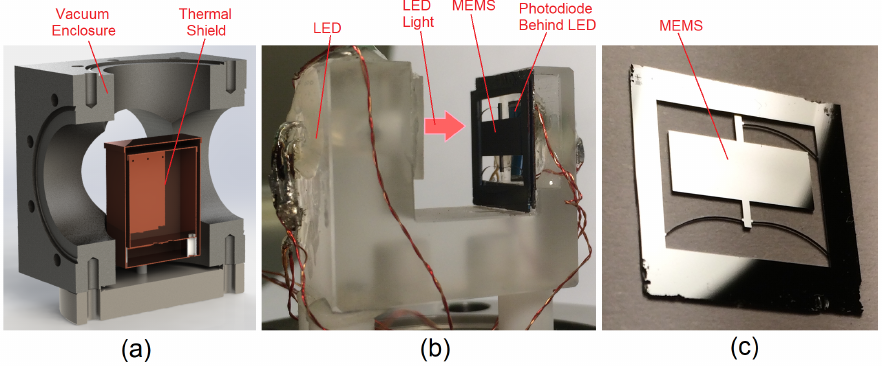
Figure 3. An image of the inside of the vacuum enclosure seen in Figure 2. Image ( a ) is a computer- generated cut-through of the stainless steel vacuum enclosure and the copper thermal shield. Image ( b ) is a photograph of the optical shadow sensor with the MEMS device mounted in its correct position. The light emitting diode (LED) shines light on the photodiode; as the MEMS moves through this light, the change in shadow creates a change in the photodiode output. The wires in this image are used to power the LED, carry the signal from the photodiode, monitor the temperatures of several components, and input power to resistive heaters used to control the temperature of the system to variation of a few mK. Image ( c ) is a close-up photograph of the silicon MEMS device itself: a central mass is suspended from anti-spring